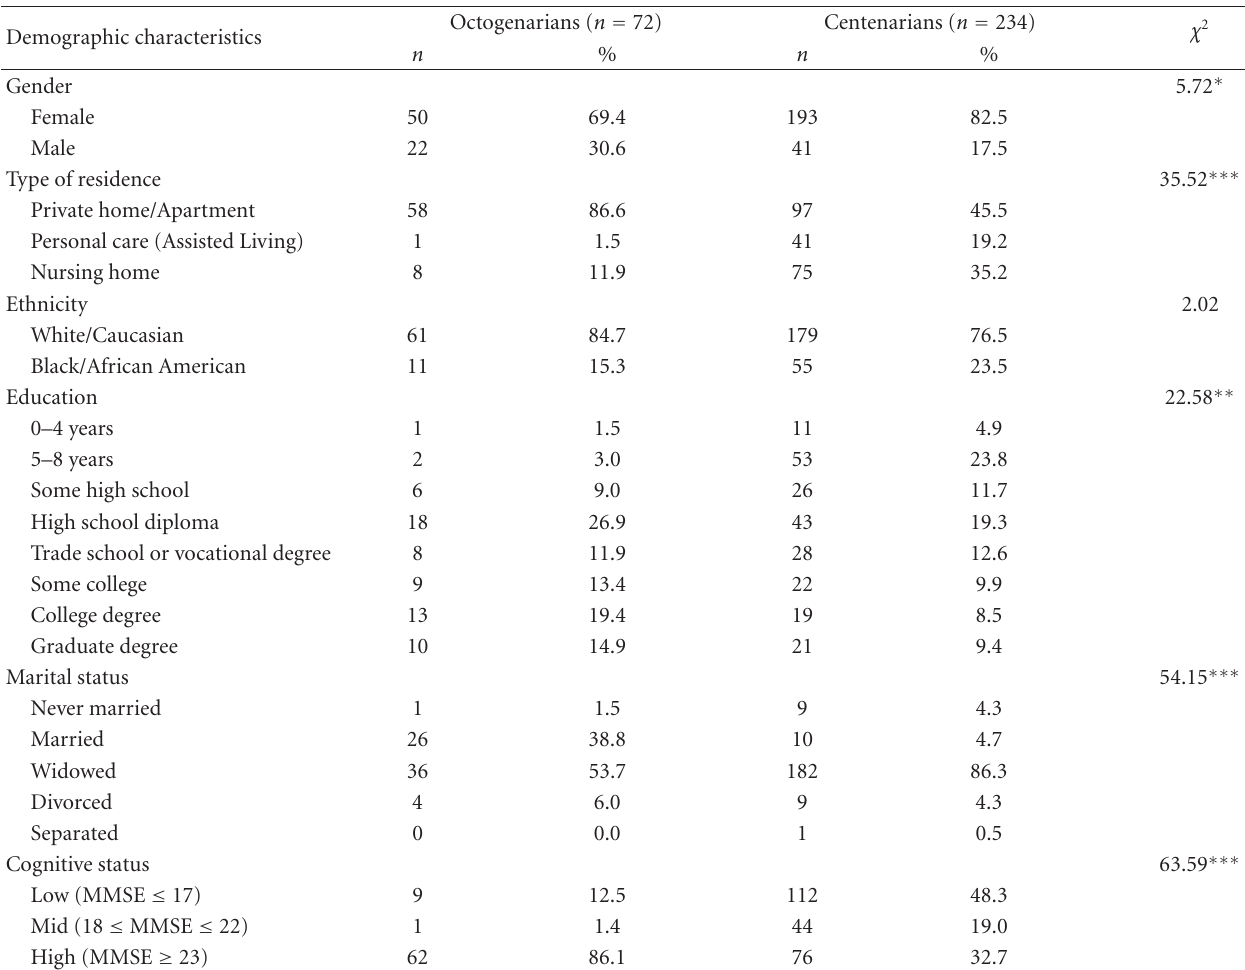
Table 1: Summary of semographic